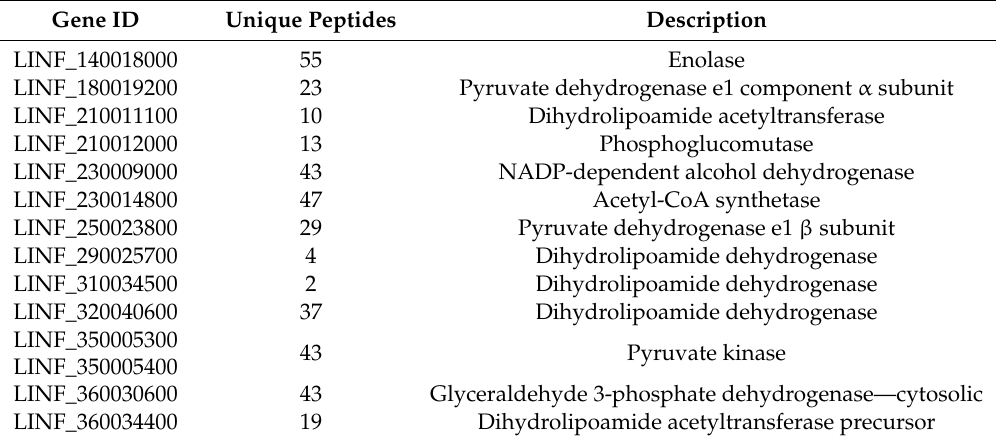
Table 2. List of cytosolic enzymes related to gluconeogenesis and glycolysis identified in the L. infantum proteome (according to the KEGG pathway